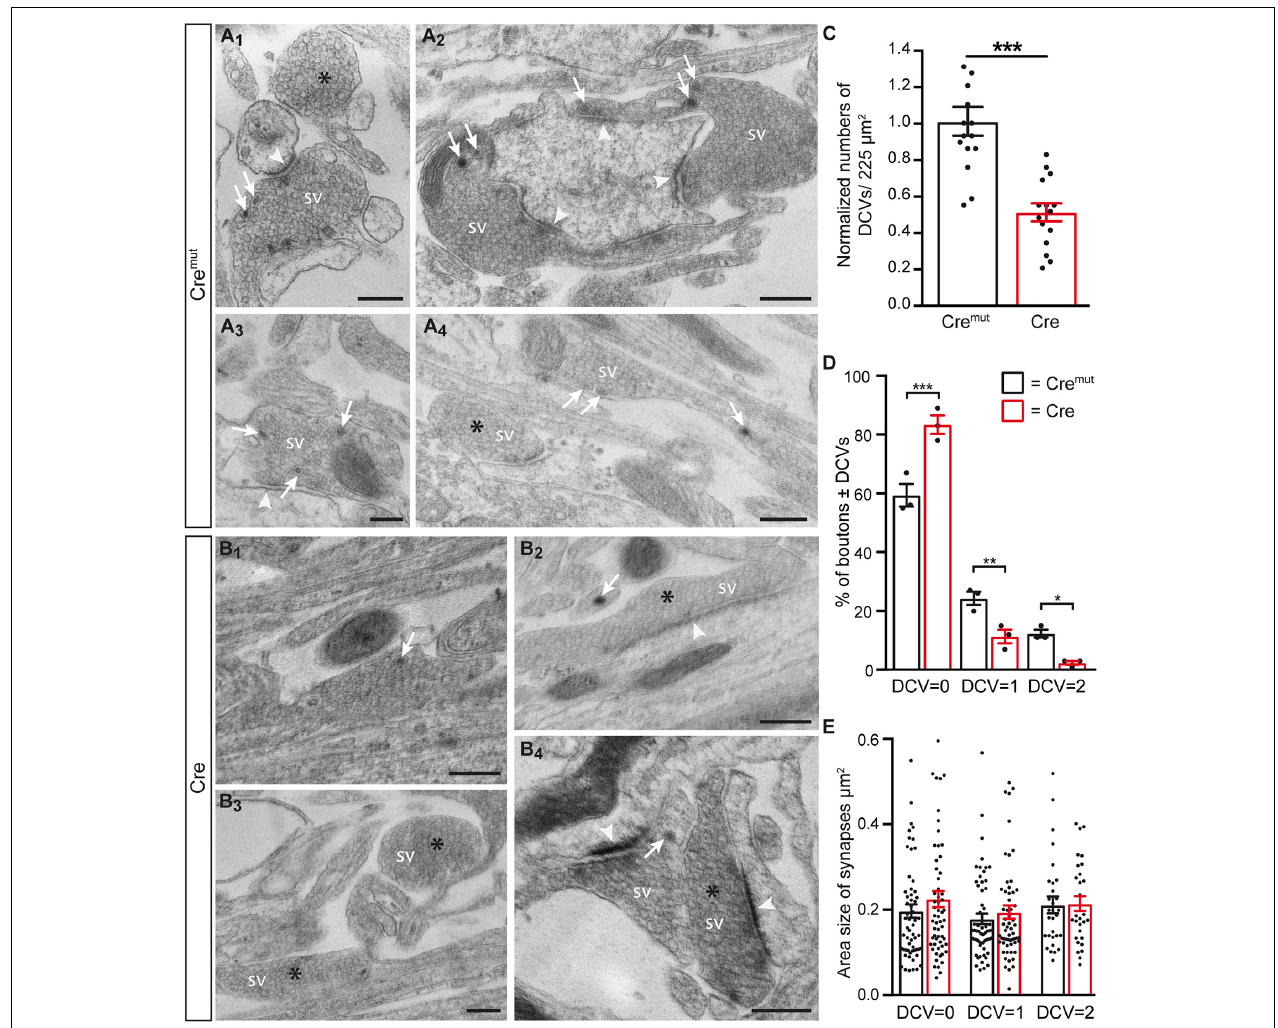
FIGURE 2 | Reduced number of DCVs in presynaptic terminals of β -Nrxn-deficient hippocampal neurons. (A) Representative transmission electron microscopic images of synaptic boutons from primary hippocampal neurons of floxed β -KI mice at DIV18 that were transduced with lentivirus expressing inactive Cre recombinase (Cre mut ). Presynapses of these cultured control neurons often contain 1 or more DCVs (arrows, A 1 –A 4 ). Boutons without DCV are marked by asterisks (A 1 ,A 4 ) . SV, synaptic vesicle clusters; arrowheads, postsynaptic densities. Scale bar: 250 nm. (B) Ultrastructure of synaptic boutons as in panel (A) but from β -Nrxn-deficient (Cre) neurons revealing fewer presynapses with DCVs (arrows, B 1 ,B 2 ,B 4 ) and more without DCVs (asterisks, B 2 –B 4 ). Scale bar: 250 nm. (C) Histogram showing the area density of DCVs in synaptic boutons of Cre mut control (black bars) and β -Nrxn-deficient Cre (red bars) neurons as shown in panels (A,B) . Numbers of DCVs were normalized to control values (for actual values, see section “Results”). Data are shown as mean ± SEM; dots indicate individual data points, measurements are based on n = 15 areas from three independent cultures per genotype; significance difference indicated as *** p < 0.0001, two-tailed unpaired t -test. (D) Histogram displaying the percentage of presynaptic boutons without DCV = 0, a DCV = 1, or DCV = 2. on random cross-sections of Cre mut control (black bars) and β -Nrxn-deficient Cre (red bars) cultures as analyzed in panel (C) . Note the increase of synaptic profiles without DCVs upon the deletion of β -Nrxn. Data are shown as mean ± SEM; dots indicate individual data points. The relative distribution is based on n = 162 (DCV = 0), n = 64 (DCV = 1), and n = 32 (DCV = 2) boutons of Cre mut neurons, and on n = 235 (DCV = 0), n = 33 (DCV = 1), and n = 7 (DCV = 2) boutons of Cre neurons from the three independent cultures per genotype; significance difference indicated as *** p < 0.0001, ** p < 0.01, or * p < 0.05, one-way ANOVA with Holm–Sidak’s multiple comparison. (E) Similar histogram to panel (D) showing the average area size of boutons without or with DCVs from Cre mut control (black bars) and β -Nrxn-deficient Cre (red bars) neurons. Data are shown as mean ± SEM. Measurements are based on n = 60 (DCV = 0 and DCV = 1) or n = 30 (DCV = 2) boutons from the three independent cultures per genotype; significance difference indicated as n.s. = non-significant, two-tailed unpaired t